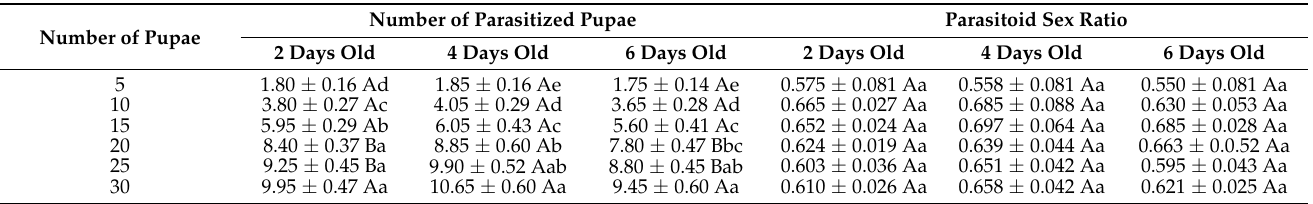
Table 1. Number of parasitized pupae and progeny sex ratio in Spalangia endius parasitizing Bactrocera cucurbitae pupae.